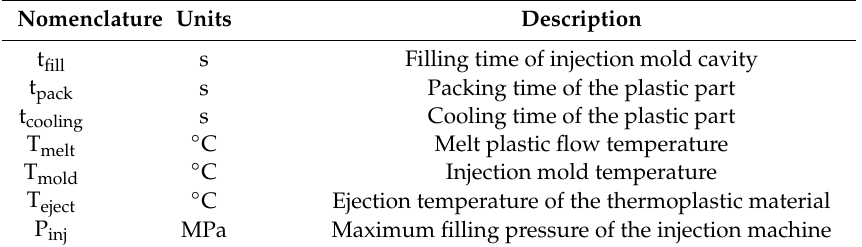
Table 1. Definition of the filling stage technological variables.